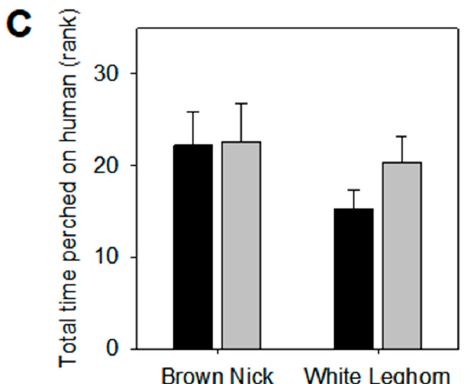
Figure 3. Results of the Voluntary Human Approach test for the parameters latency to walk, time in zone 3, and total time on human. No significant effects were seen on these parameters. Bars represent averages and SEM of ranked data.